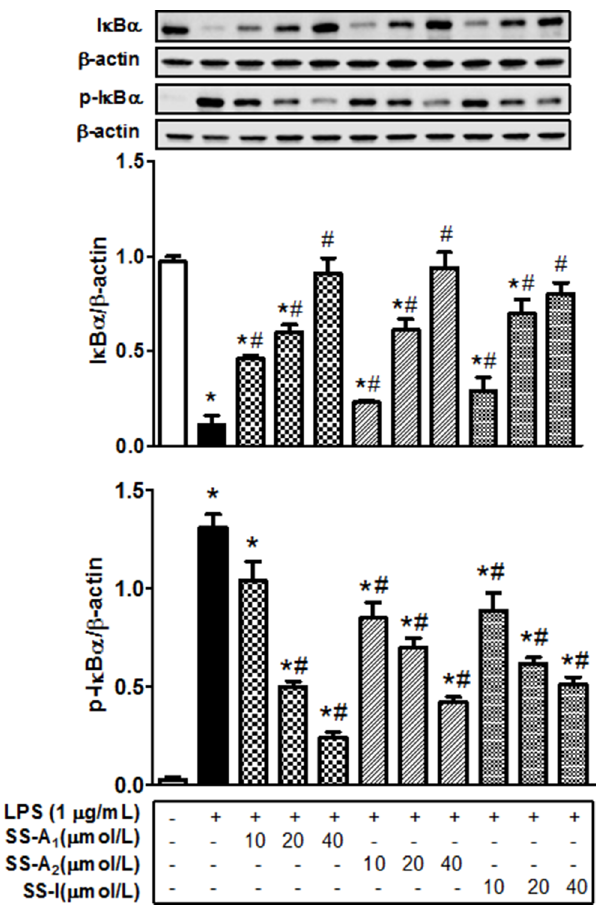
Figure 5. Soyasaponins influence the LPS-stimulated activation of NF-kB through modulation of IKK a / b phosphorylation in macrophages. Macrophages were pre-treated with 10, 20, or 40 m mol/L of soyasaponins (A 1 , A 2 and I) for 2 h, and then stimulated with LPS (1 m g/mL) for 15 min as indicated. Phospho-IKK a / b and total IKK b were detected by immunoblotting and b -actin was used as a control. Results are presented as means 6 SD of 3 independent experiments. *: P , 0.05 vs. control. # : P , 0.05 vs. LPS